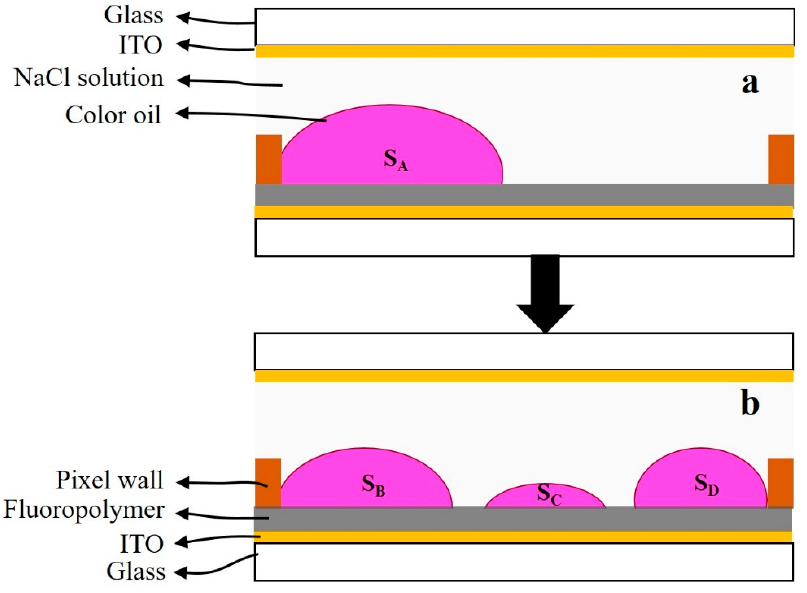
Figure 2. The situation of oil film contraction when a driving voltage is applied to a pixel. ( a ) A complete oil film contracts to a corner of the pixel without splitting; S A is the base area of the oil film. ( b ) The oil film was split into three pieces, and each piece contracts to different corners of the pixel; S B , S C and S D are the base areas of the three split oil